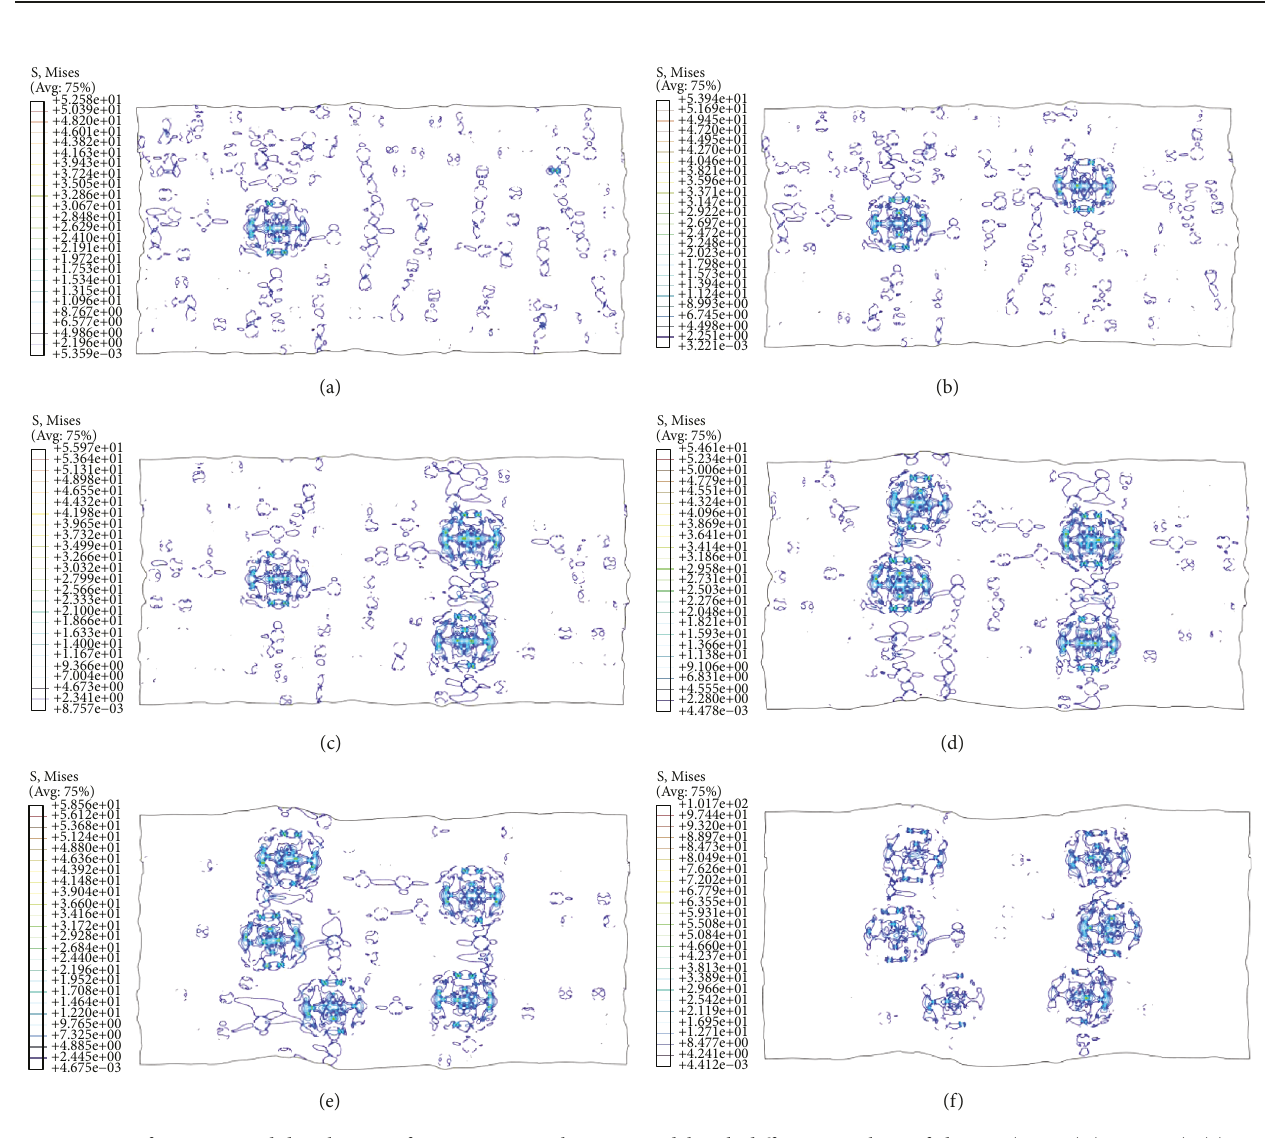
Figure 14: Deformation and distribution of Mises stress in the RVE model with di ff erent numbers of clusters ( ε = 0 4 ) (same size): (a) one cluster, (b) two clusters, (c) three clusters, (d) four clusters, (e) fi ve clusters, and (f) six